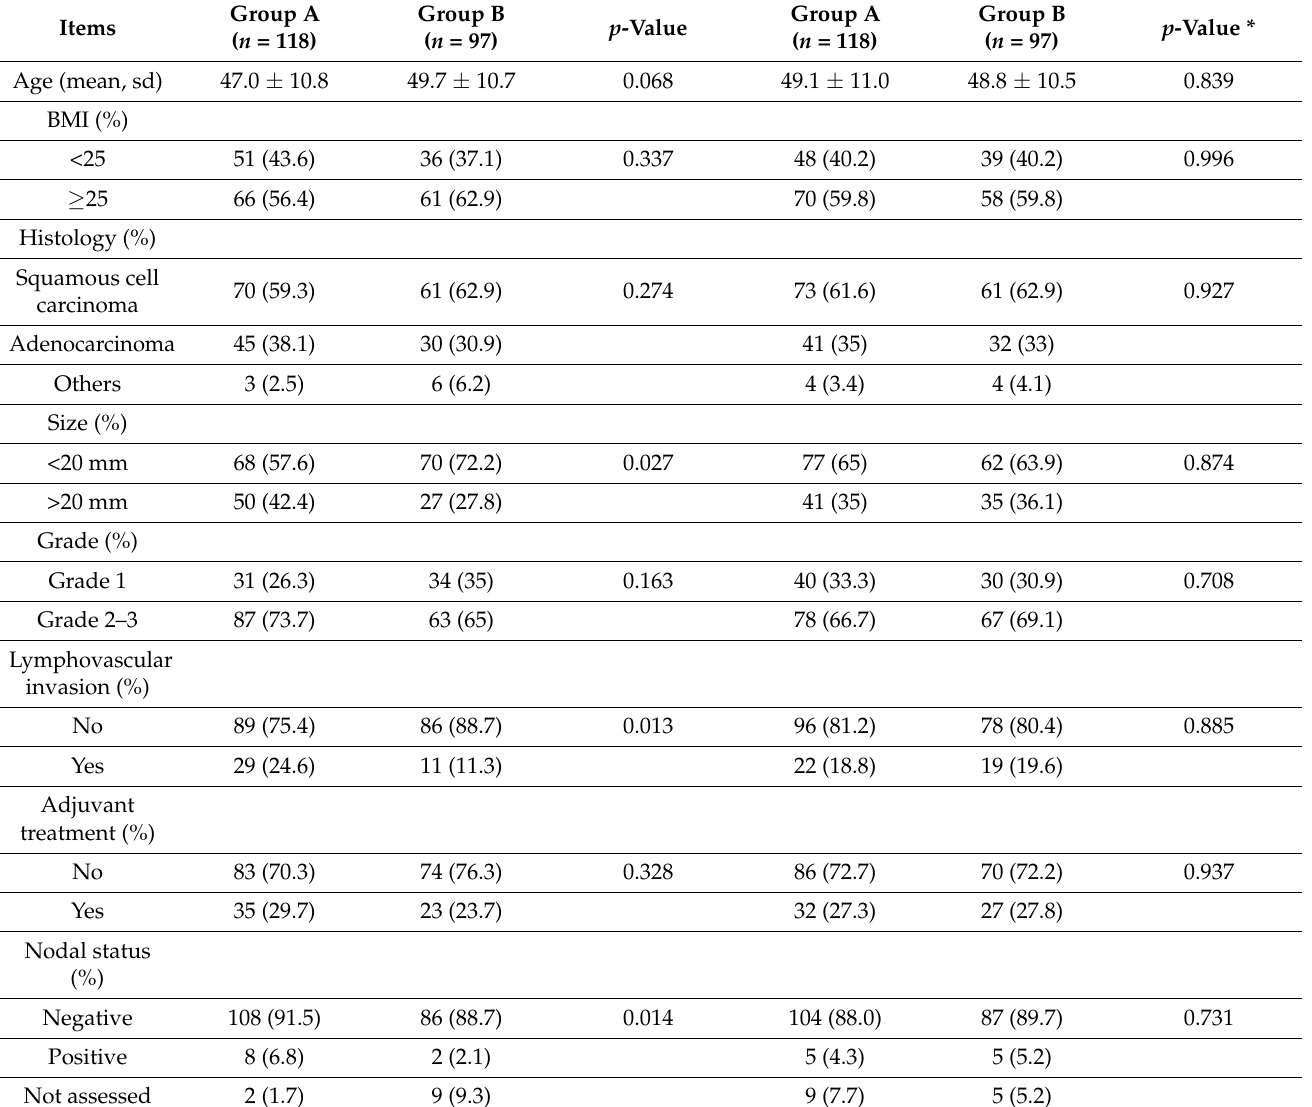
Table 2. Baseline characteristics of the patients in groups A and B in the original and the balanced